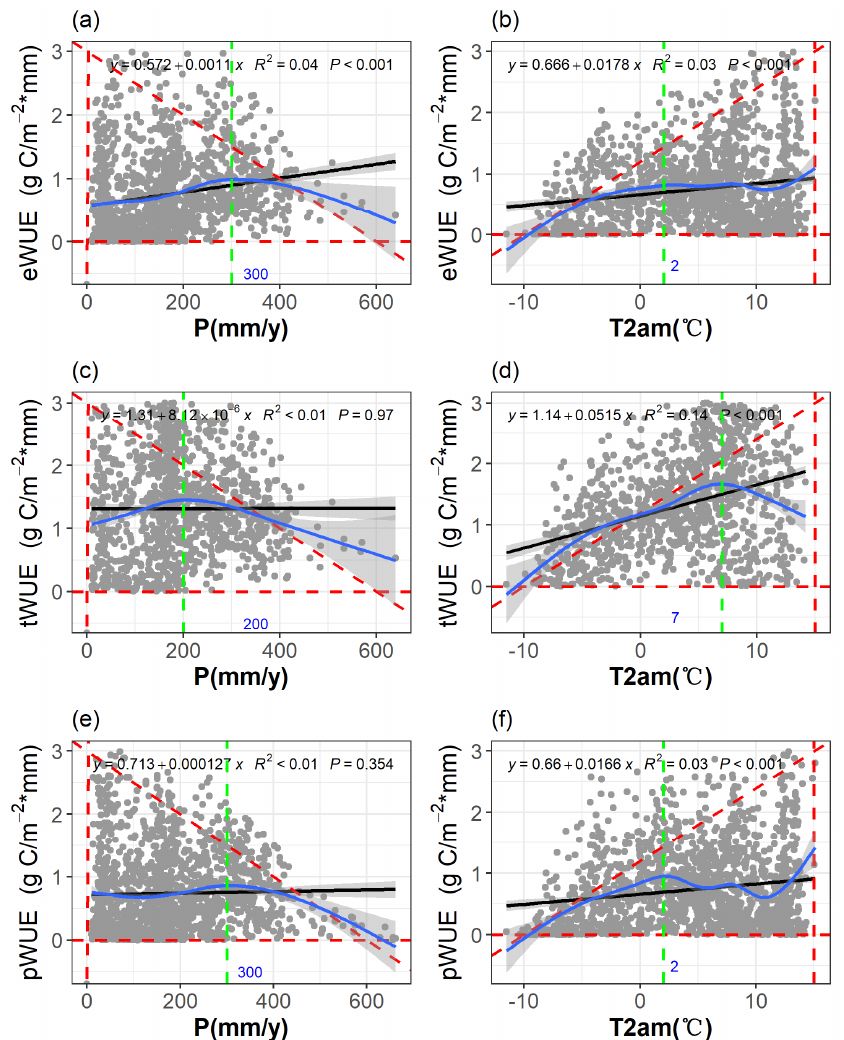
Figure 8. Relationship between precipitation, temperature, and WUEs. (The black line represents linear fitting; the blue line represents the variation trend of the fitting points. The gray is the 95% confidence interval, and the dashed green line is the